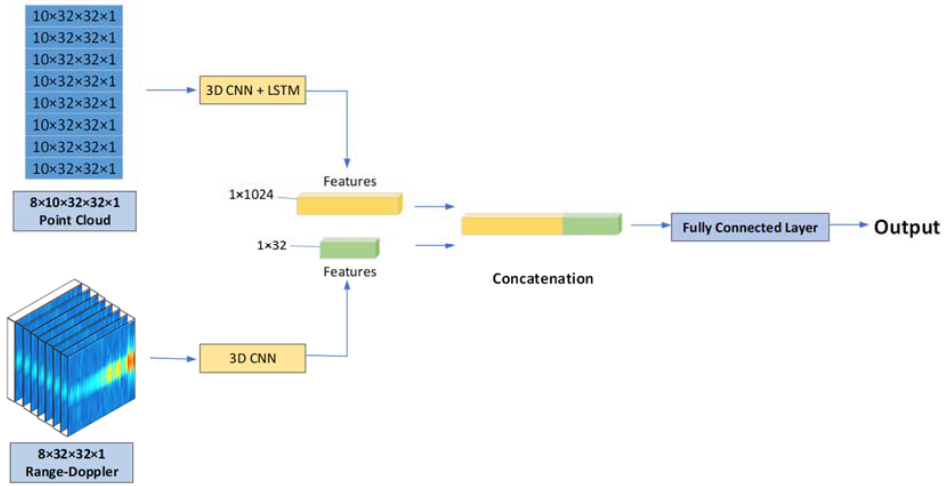
Figure 8. The structure of the fusion network.